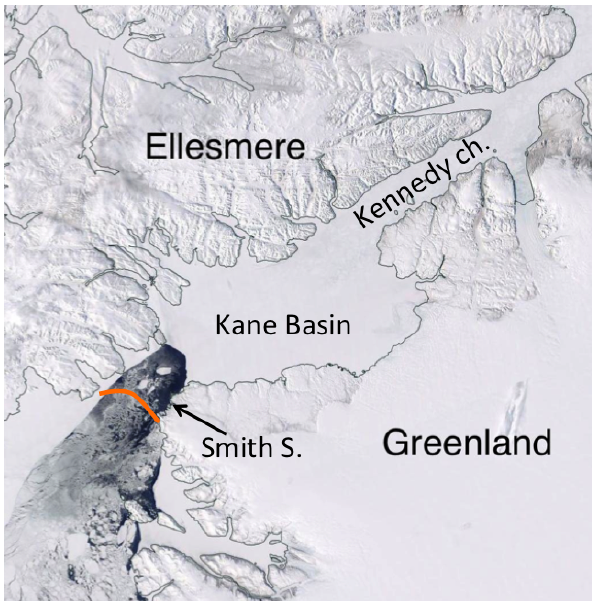
Figure 1. NASA Worldview image of a stable landfast ice arch in Nares Strait, from Moderate Resolution Imaging Spectrora- diometer (MODIS)-corrected reflectance imagery (true color), on 1 May 2018. The orange curve indicates the position of the stable ice in Dansereau et al.